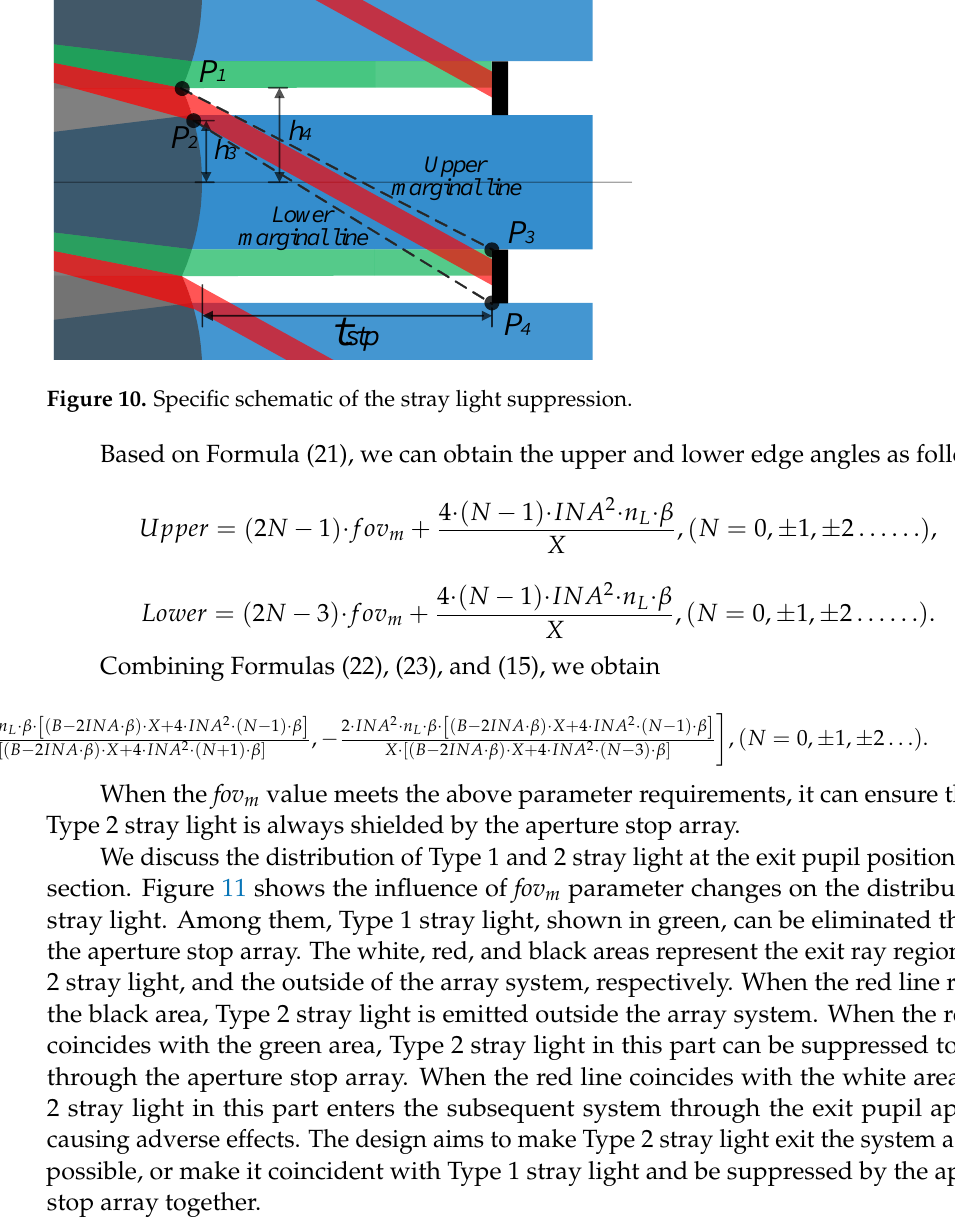
Figure 9. Schematic of the stop placement of an array system.